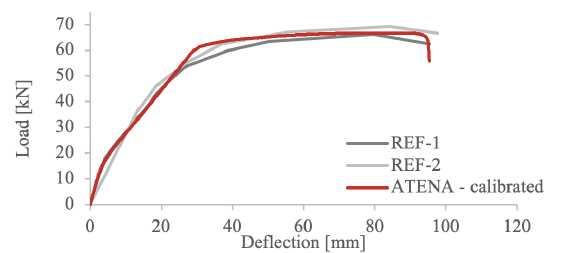
Figure 5. The experimental force-CMOD curve compared with the FE analysis results (with default material parameters and after the calibration proce-